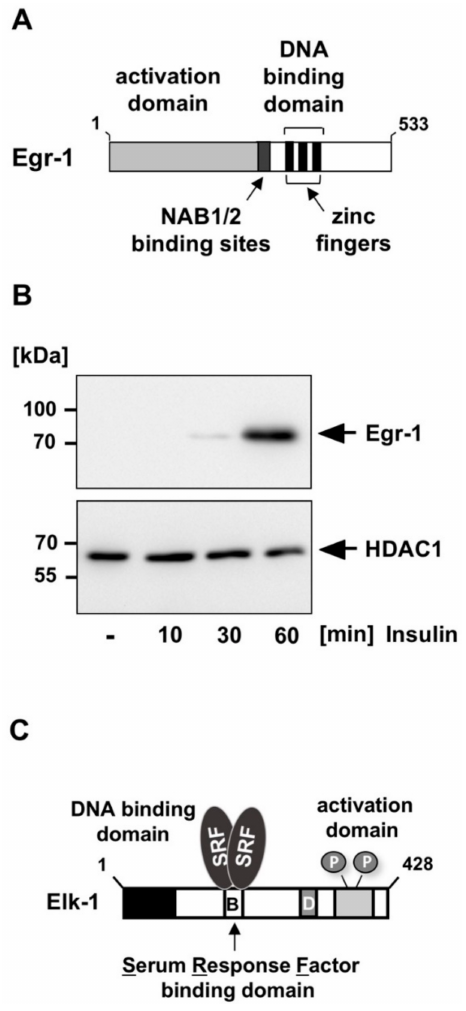
Figure 2. Insulin receptor stimulation activates the biosynthesis of the zinc finger transcription factor Egr-1 under the control of Elk-1. ( A ) Modular structure of Egr-1. The protein has an extended N-terminal activation domain and a C-terminal DNA binding domain with three zinc finger motifs as DNA interaction domain. In addition, there is a binding site for the transcriptional co-repressor proteins NAB1 and NAB2. ( B ) Insulin treatment of insulin receptor-expressing HIRcB cells induced the biosynthesis of Egr-1. HIRcB cells were cultured for 24 h in medium containing 0.05% serum and then stimulated with insulin (100 nM). Nuclear extracts were prepared and subjected to Western blot analysis. The blot was developed with an antibody directed against Egr-1. An antibody detecting histone deacetylase-1 (HDAC1) immunoreactivity was used as a loading control. Reproduced with modifications from ref. [7] with permission from Elsevier. ( C ) Modular structure of Elk-1. The protein has an N-terminal DNA binding domain and a C-terminal activation domain. The B domain is the interaction domain with serum response factor. The domain D is the interaction site for ERK1/2 and c-Jun- N -terminal protein